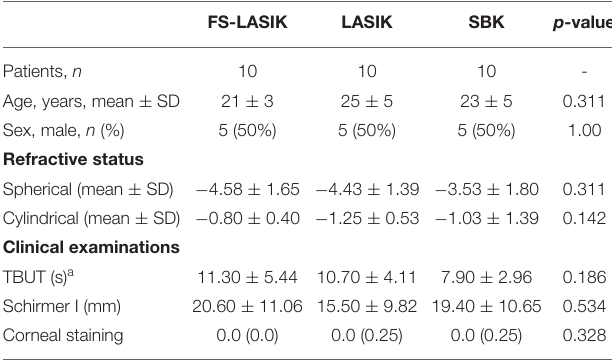
TABLE 1 | Characteristics of the patients receiving FS-LASIK, LASIK, or SBK surgery. FS-LASIK